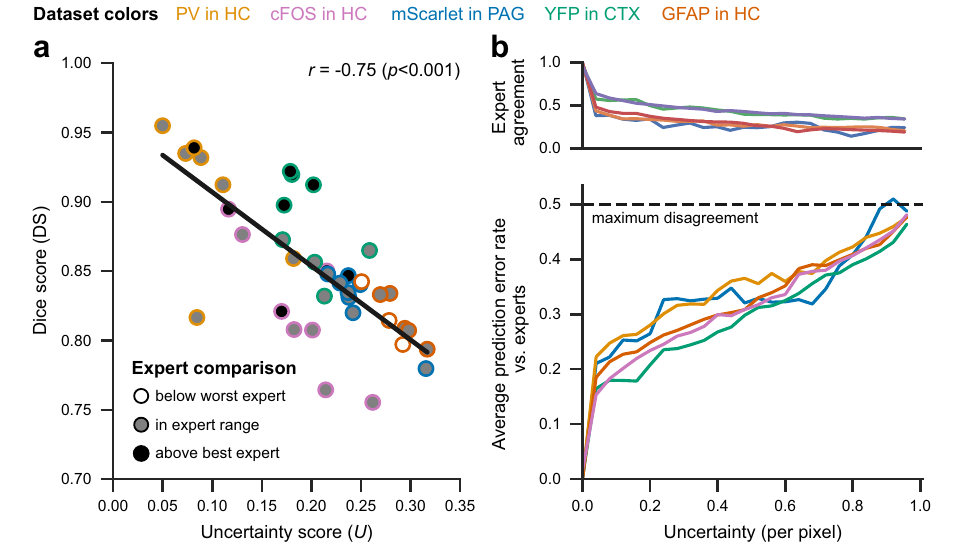
Fig. 4 | Relationship between expert annotations, uncertainty, and similarity scores. a Correlation between Dice scores and uncertainties on the test set. We quantify the linear correlation using Pearson ’ s r and a two-tailed p -value ( p =0.00000002) for testing non-correlation. The grayscale fi lling depicts the comparison against the expert annotation scores. b Relationship between pixel-